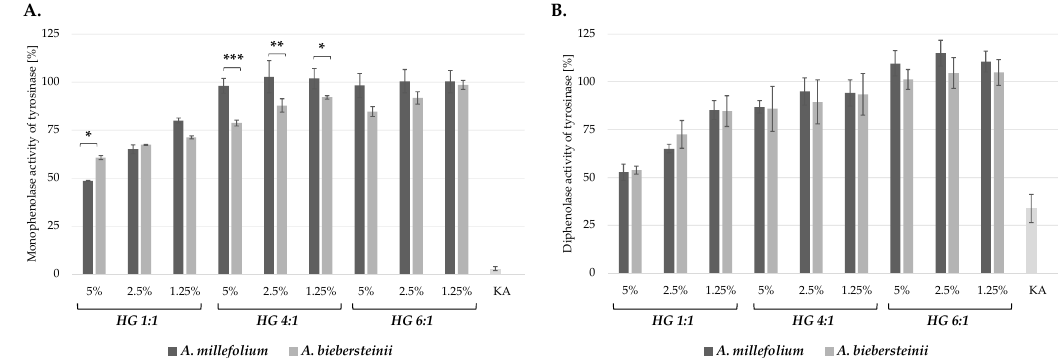
Figure 1. Inhibitory effect of A. millefolium and A. biebersteinii extracts on the monophenolase ( A ) and diphenolase ( B ) activity of mushroom tyrosinase in comparison with 50 μ g/mL kojic acid (KA); values on graphs represent mean ± SD ( n = 3 ); * p < 0.05, ** p < 0.001, *** p < 0.0001.